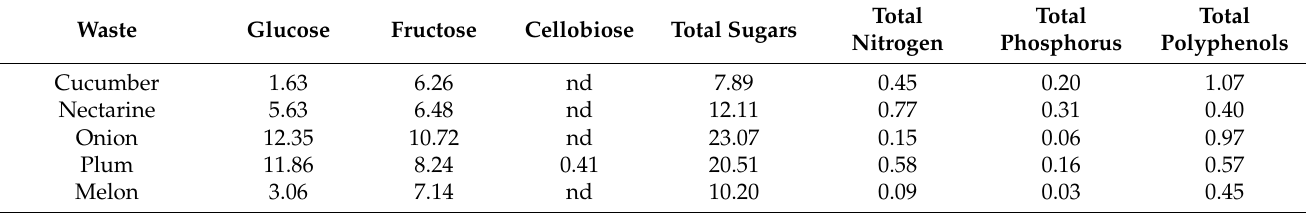
Table 2. Composition (g/L) of extracted solutions for the agricultural wastes considered in this work. Wastes labeled by * originated from industrial processes. nd: not